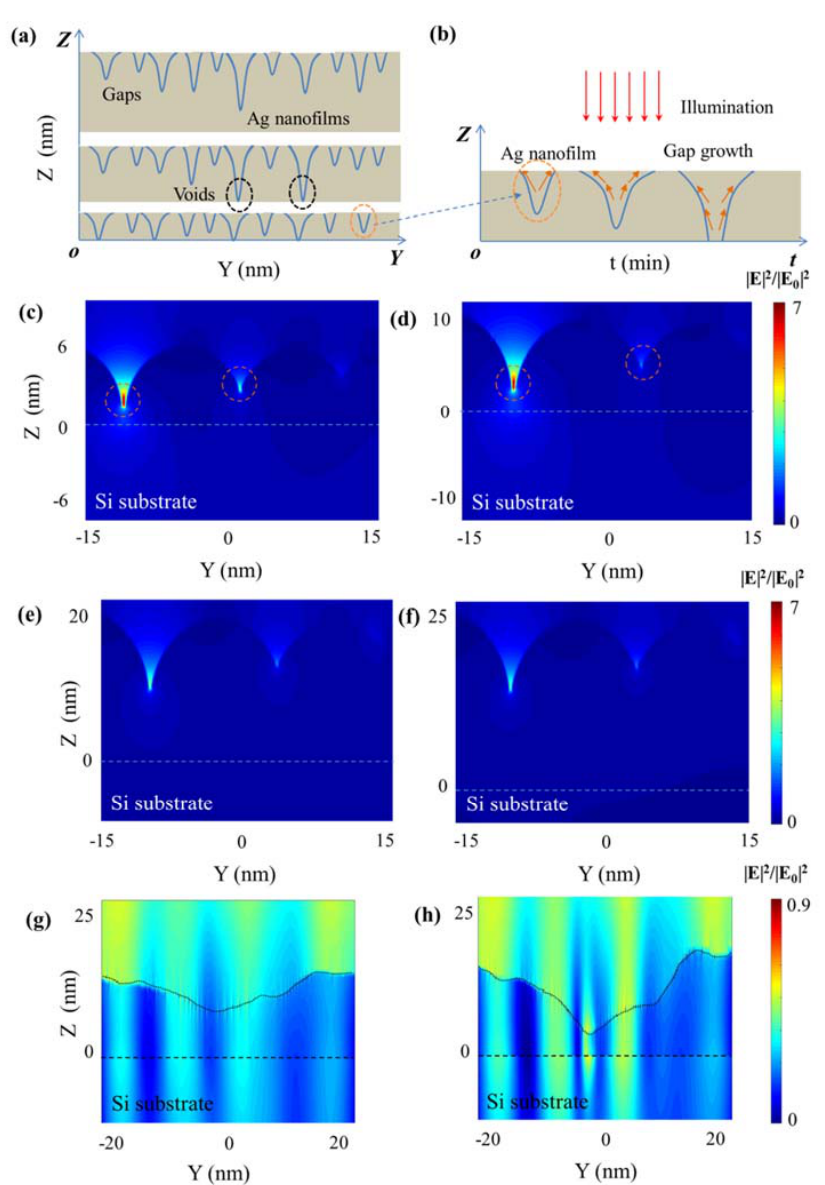
Figure 4. Voids induced plasmonic enhancement on Ag nanofilms with various thicknesses; ( a ) schematic diagram of voids in Ag nanofilms with various thicknesses; ( b ) schematic diagram of the evolution of gaps/voids in Ag nanofilms with light illumination; ( c – f ) plasmonic enhancement of gaps/voids on Ag nanofilms with 6 nm, 10 nm, 20 nm and 25 thicknesses; ( g ), ( h ) plasmonic enhancement of surface fluctuations on Ag nanofilms (thickness 10 nm) with average ±2 nm and ±4 nm.